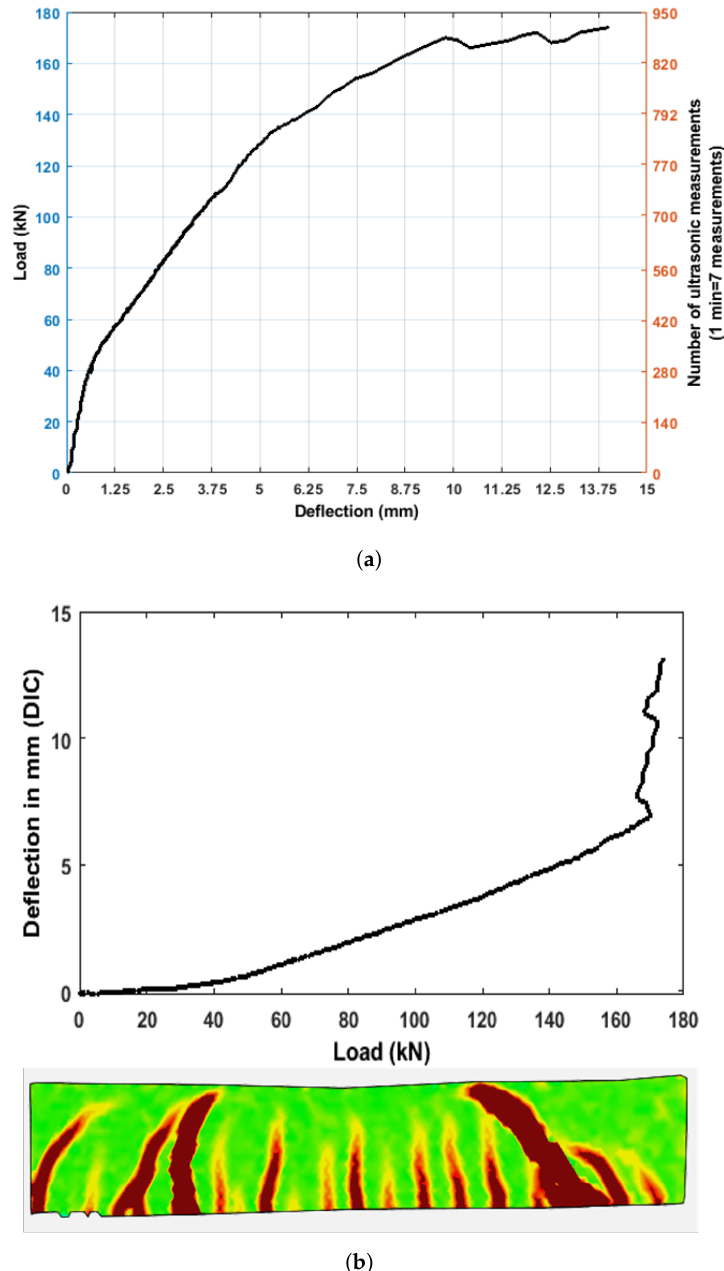
Figure 5. Deflection (DIC) at different load levels and final stage of the beam. ( a ) Deflection (LVDT) vs. load; ( b ) Strain images at different load levels and final stage of the